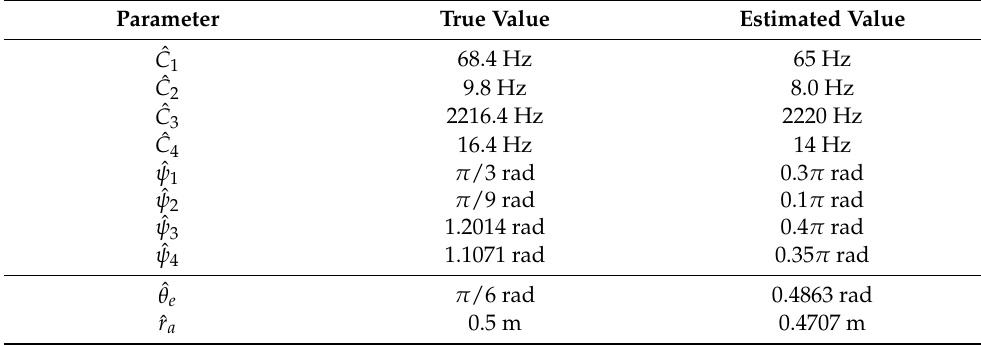
Table 3. The decomposition results of the OMP algorithm without the interference processing in time-frequency domain and